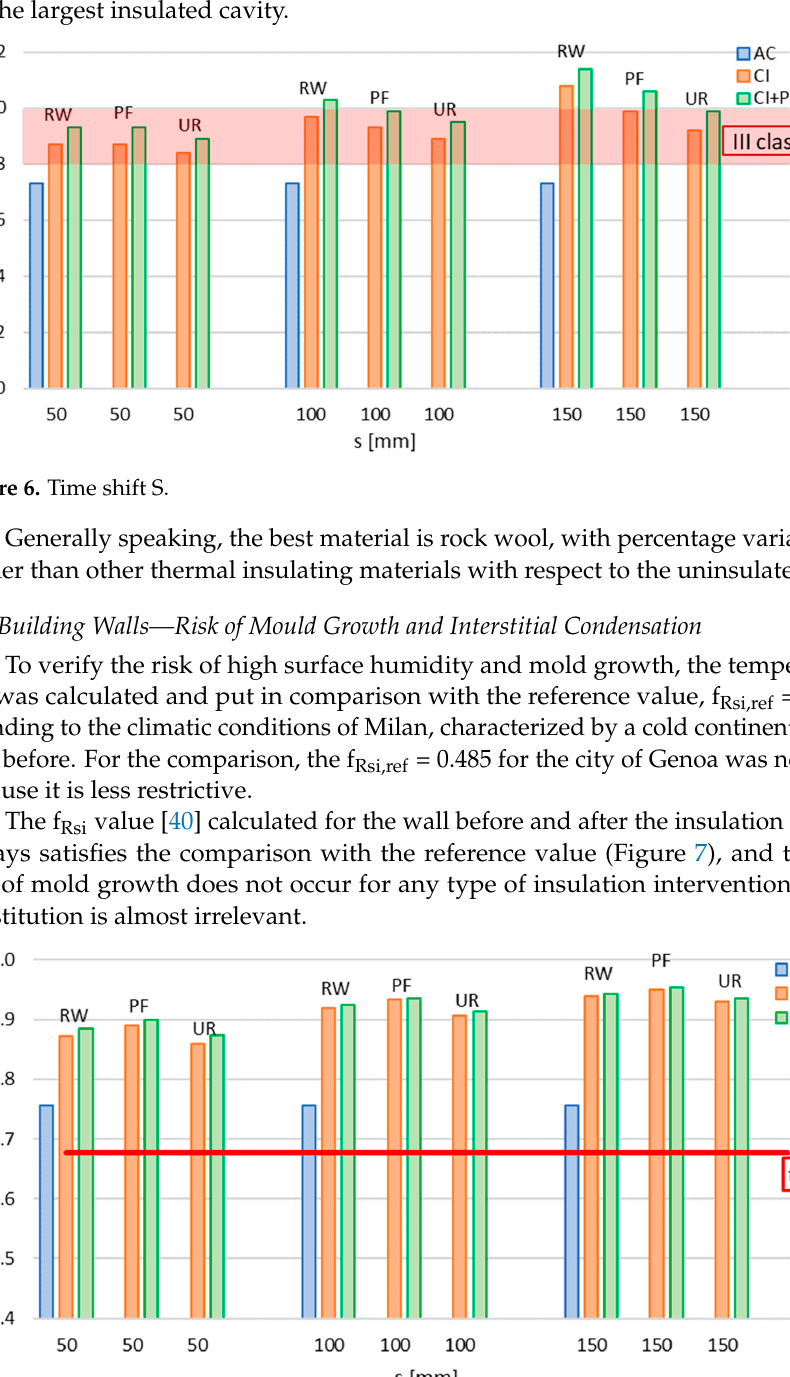
Figure 5. Decrement factor f.